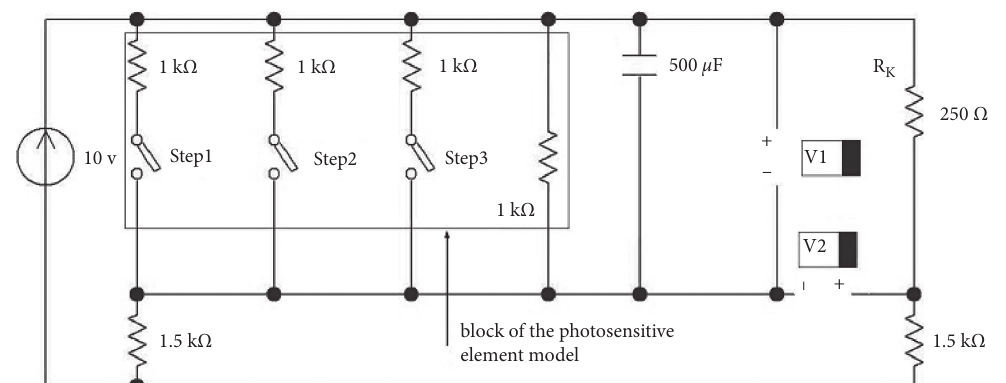
Figure 4: Connection of electric bridge with a photosensitive element.